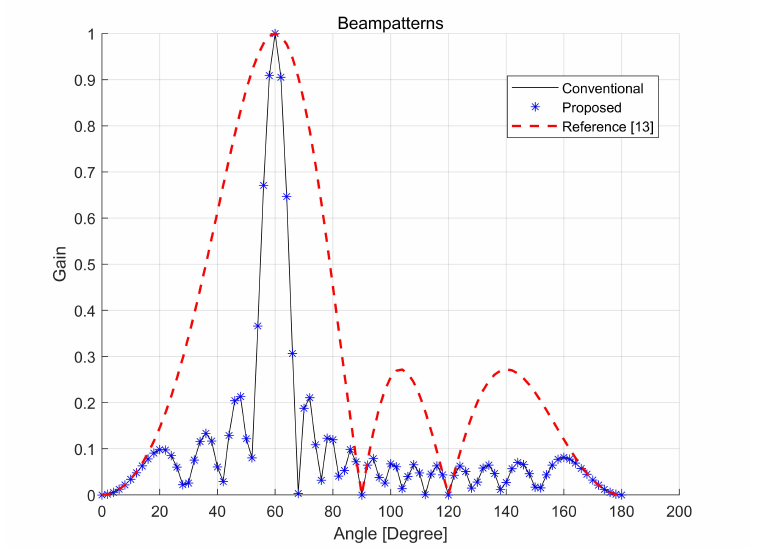
Figure 7. Comparison of beam patterns.